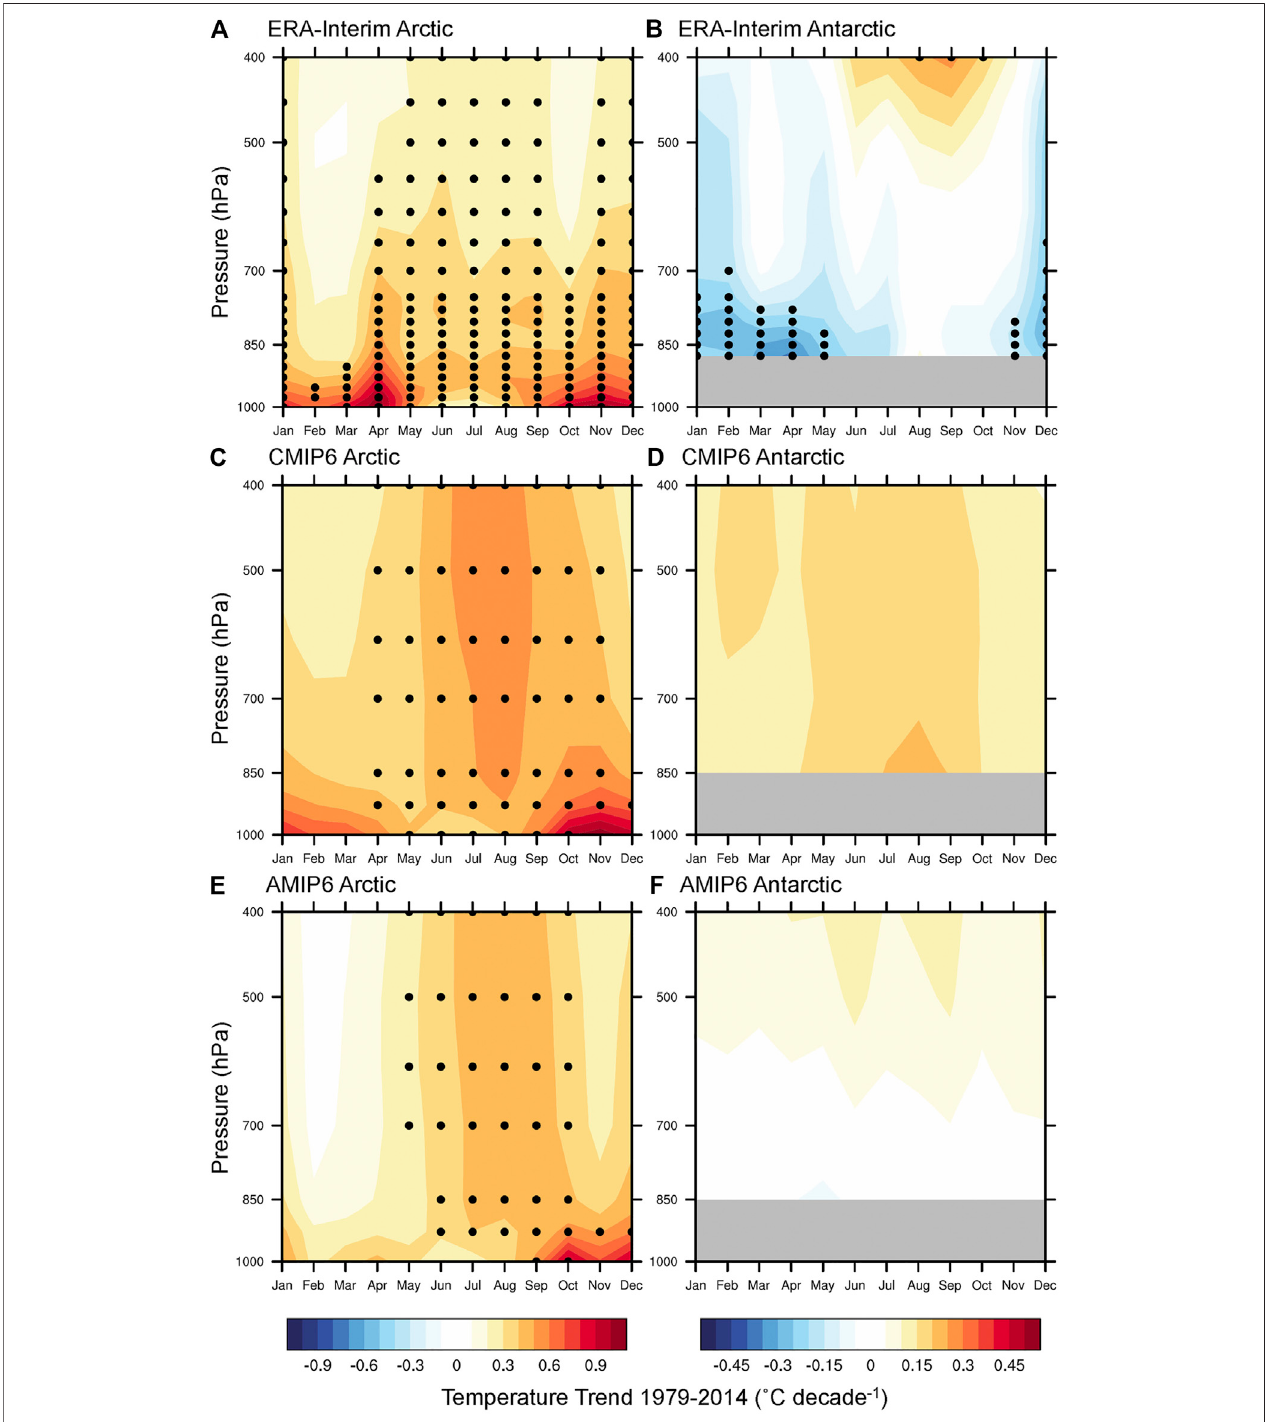
FIGURE3| Atmospheric temperature trends ( ˚ Cdecade − 1 ) for 1979 – 2014for (A,C,E) theArcticand (B,D,F) the Antarctic in theERA-Interimreanalysis (A,B) ,and historicalCMIP6 (C,D) andAMIP6 (E,F) multimodelmeantrends.Blackdotsin (A,B) showstatisticallysigni fi canttrendsatthe95%levelbasedonatwo-tailedStudent ’ s t-test, and black dots in (C,D) and (E,F) show where 75% of models meet these criteria for signi fi cant trends. For the reanalysis and models, temperature data is fi rst masked at pressures greater than the surface pressure, and trends are only shown where more than 50% of area-averaged grid points are non-missing.